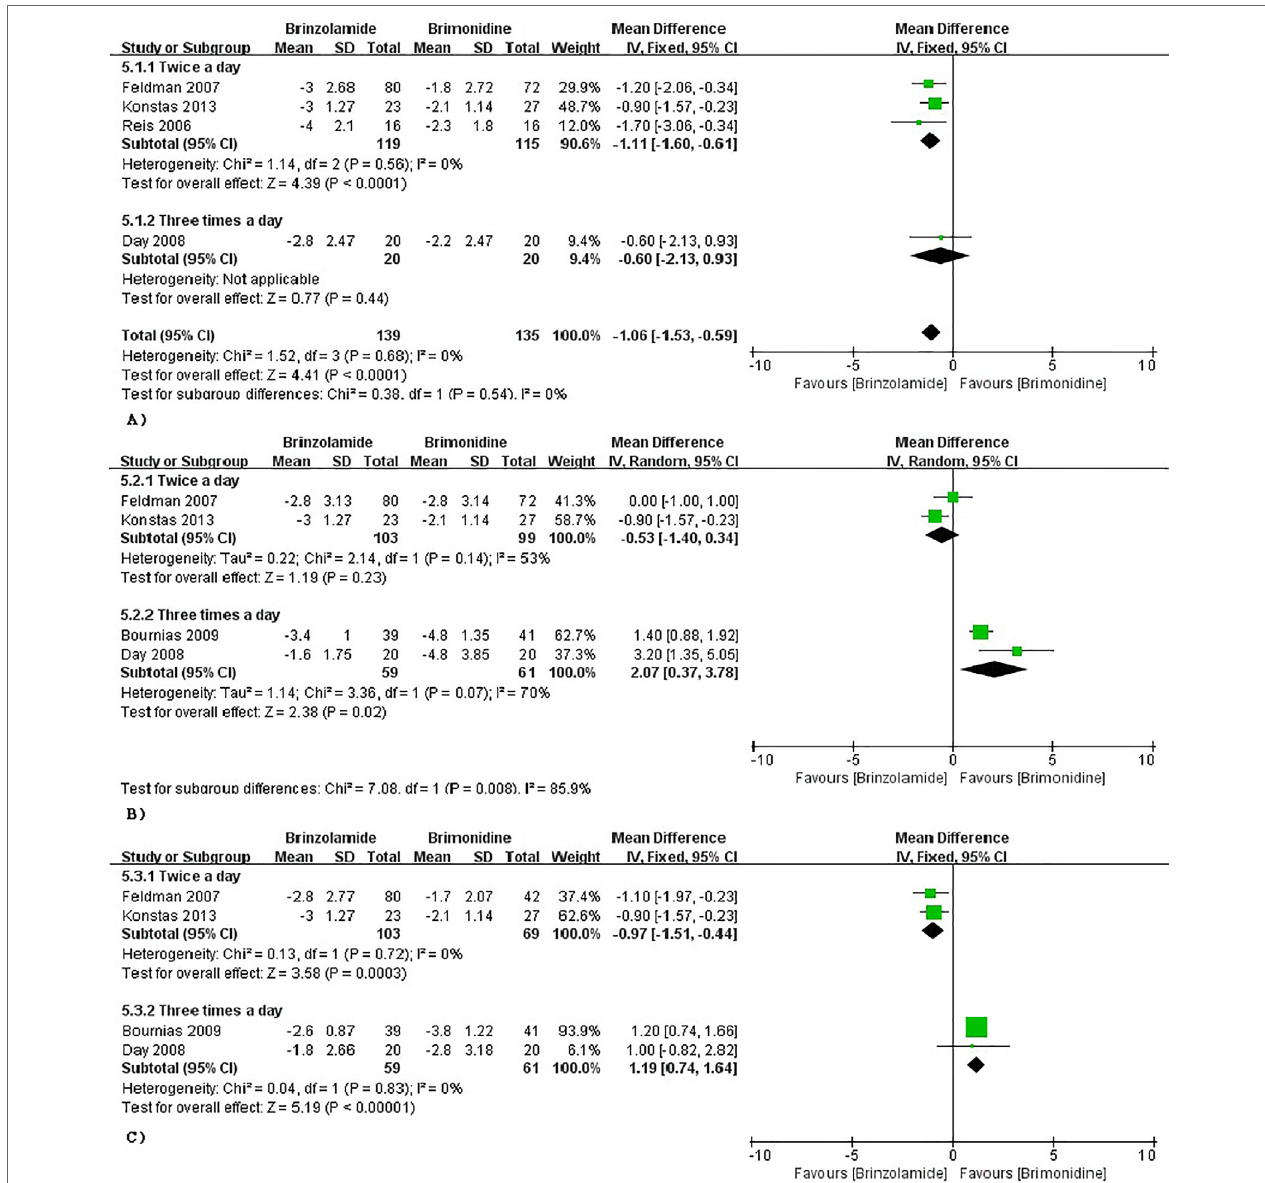
FIGURE 5 | Forest plot for IOP change from baseline (Brinzolamide group vs. Brimonidine group). The plot of change value for IOP at 9 am (A) , 12 pm (B) , 4 pm (C)